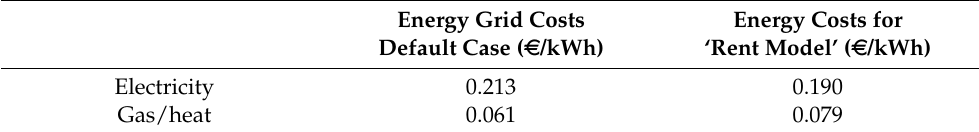
Table 6. Grid energy costs and local energy costs for ‘Rent model’.